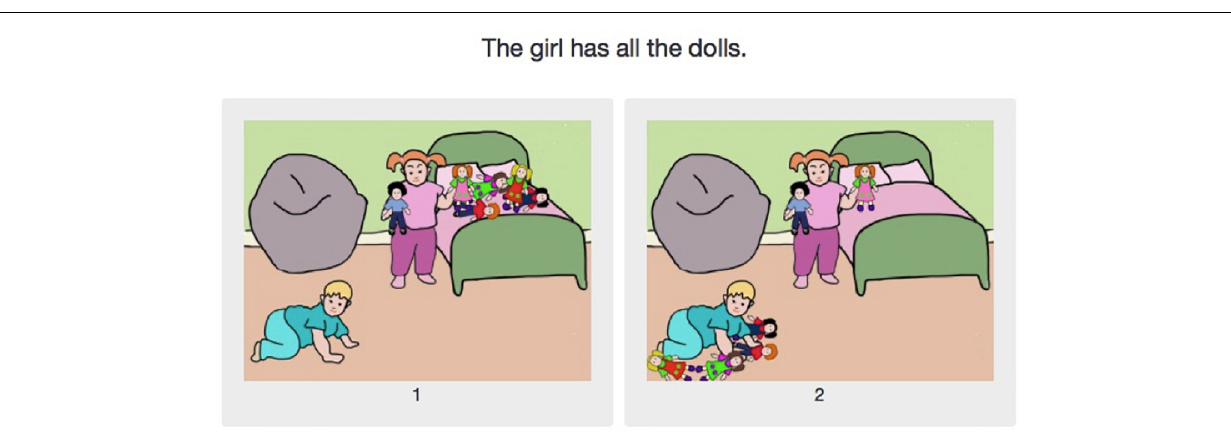
FIGURE 10 | Experiment 2: The all condition (the image verifying the sentence is on the left, the image falsifying the sentence in on the